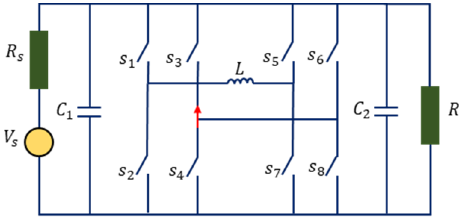
Figure 3. Simplified circuit of DAB dc-dc converter.